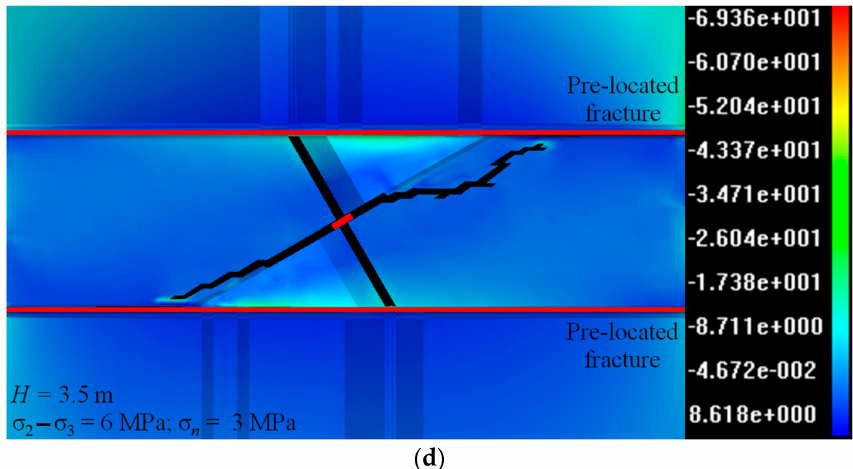
Figure 9. Evaluated PHF trajectories in Set 9 in Table 11 (the legends in ( a – d ) show the σ 3 distributions): ( a ) Evaluated PHF trajectory in Case 9-1; ( b ) Evaluated PHF trajectory in Case 9-2; ( c ) Evaluated PHF trajectory in Case 9-3; ( d ) Evaluated PHF trajectory in Case 9-4.